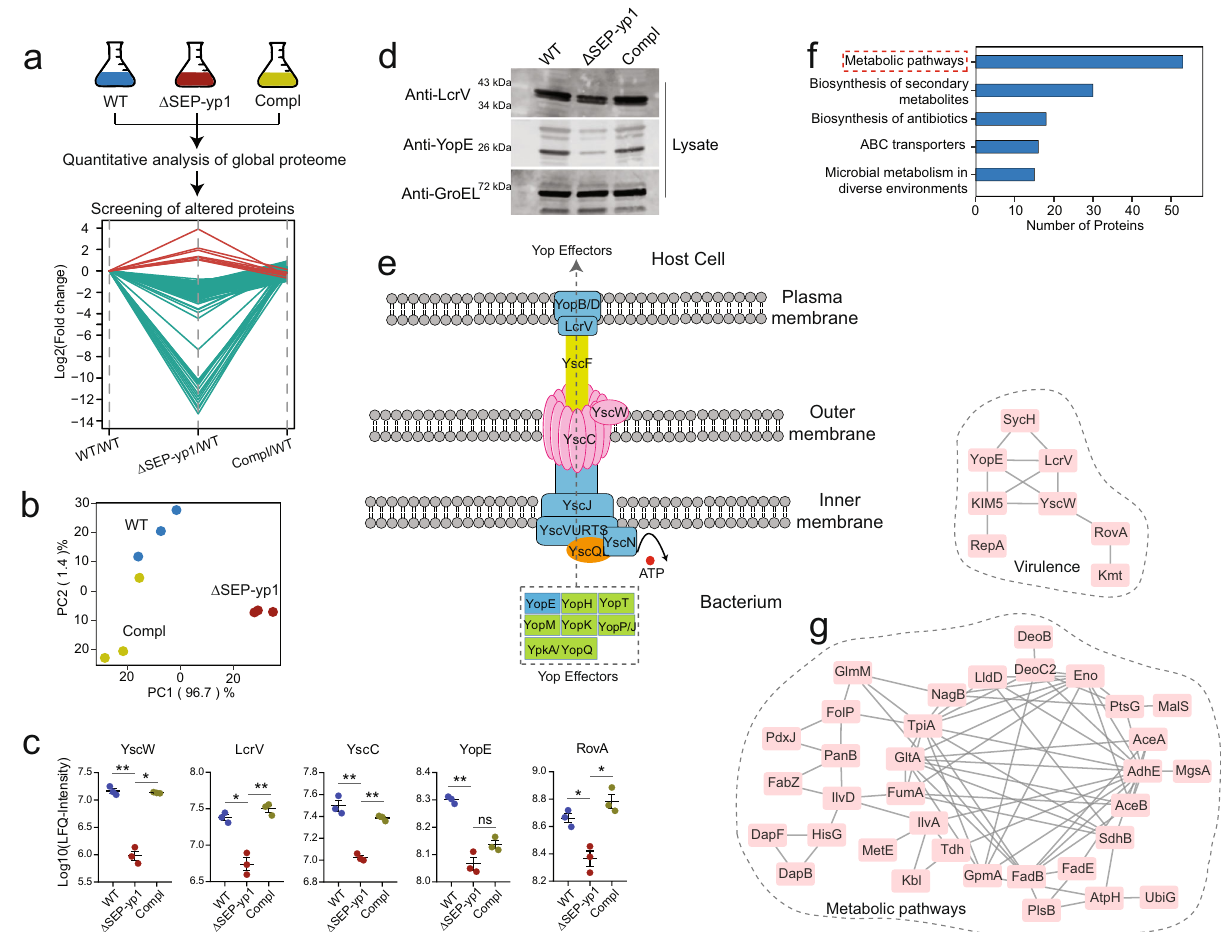
Fig. 5 Quantitative global proteome analysis of WT, Δ SEP-yp1, and Δ SEP-yp1-compl (compl) reveals that SEP-yp1 deletion reduces the expression of virulence proteins. a Experimental work fl ow of label-free quantitative proteomics for screening the altered proteins in the bacteria due to SEP-yp1 deletion. N = 3 in each group. The multiple line plot shows the 189 proteins fi ltered by the criteria: opposite alteration trends between Δ SEP-yp1/WT and Compl/ Δ SEP-yp1, p value ( Δ SEP-yp1/WT)< 0.05, p value (Compl/ Δ SEP-yp1)< 0.05, and p value (Compl/WT) > 0.05. b PCA analysis of all the quanti fi able proteins in the three groups. c Scatter plots show the alteration of four altered virulence factors as well as RovA by quantitative proteomics. The statistical signi fi cance was calculated by unpaired t test adjusted by Benjamini – Hochberg procedure with FDR < 0.01. * P value < 0.05 and ** p value < 0.01; ns nonsigni fi cant. Error bars represent SEM. d Orthogonal validation of altered proteins by Western blotting. Each experiment has three biological replicates. e Schematic representation of Yersinia type III secretion apparatus. f KEGG analysis of the 189 altered proteins due to SEP-yp1 knockout. g Mapping the altered proteins onto the protein interaction network using the STRING database. One cluster represents the proteins involved in the metabolic pathways from KEGG analysis and another is associated with bacterial virulence. Refer to Supplementary Data 5 for